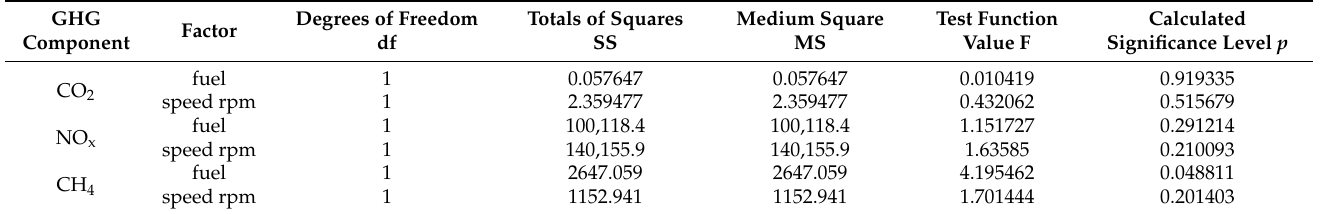
Table 9. ANOVA results for emission levels (volume shares) of GHG components due to fuel and engine speed (biodiesel, ON).